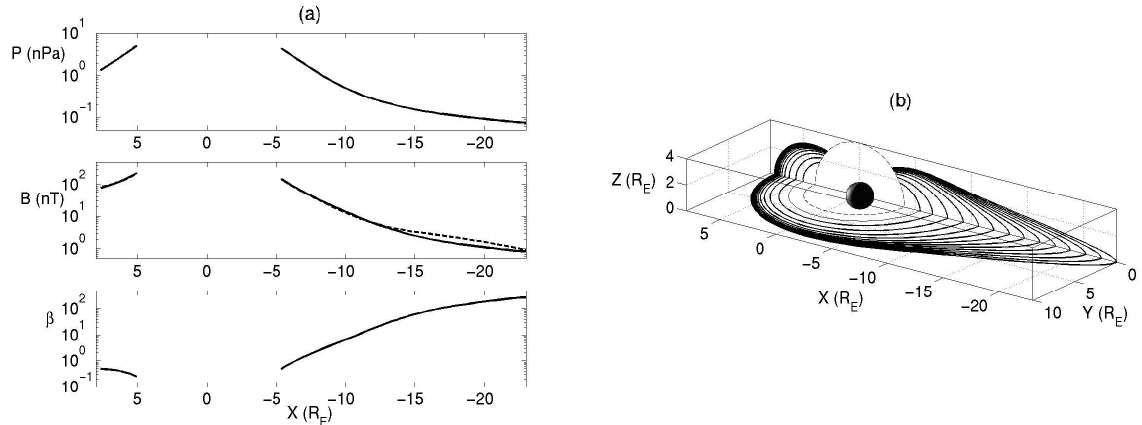
Fig. 3. (a) Profiles along the Sun-Earth axis for P , | B | and β in the quiet-time 3-D equilibrium with Spence-Kivelson pressure; the dashed line in the second plot represents | B | from the T96 model; (b) Noon-midnight and equatorial plane cross sections of constant flux surfaces in the northwestern quadrant for the computed 3-D equilibrium; dashed lines show semi-circles of radius 4 R E , corresponding to the sphere at the inner domain boundary.